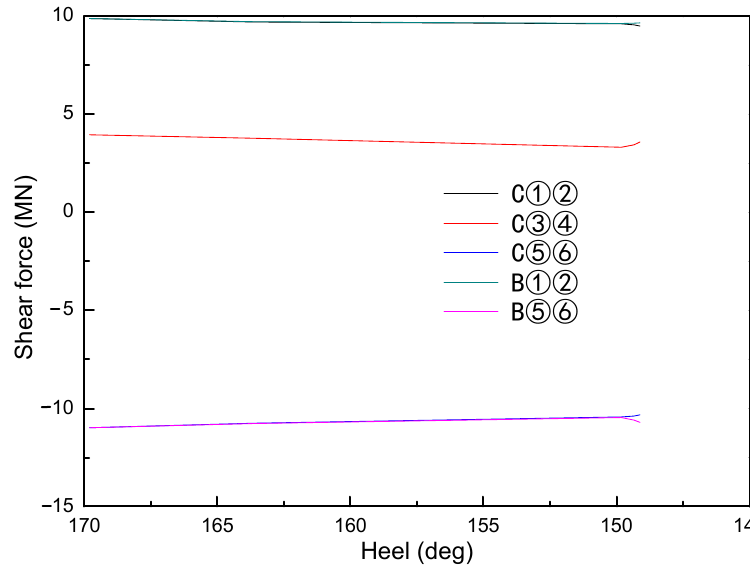
Figure 3. Variation of shear force under case Ⅰ .